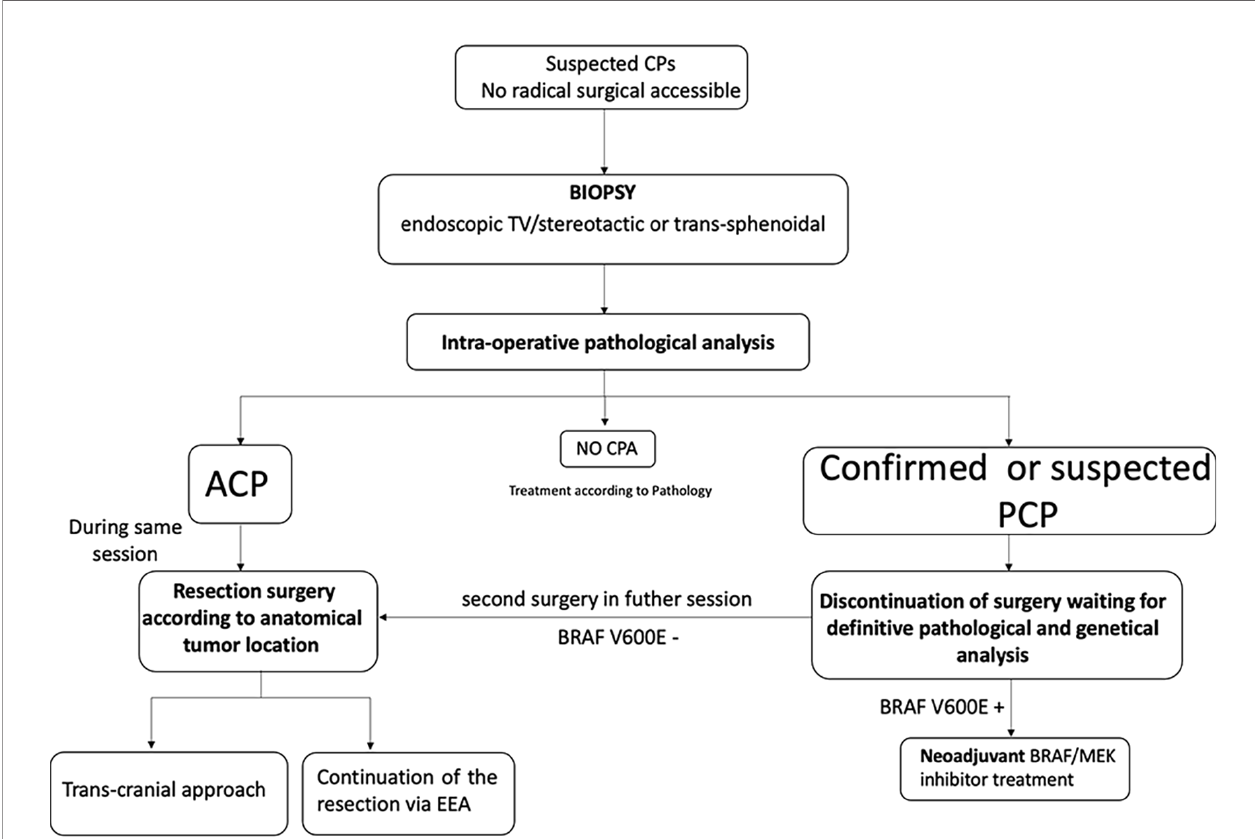
FIGURE 4 | Proposed management algorithm for introperative decision making using pathological analysis on frozen section. Depending on tumor anatomical location, the biopsy can be performed either by stereotactic and neuroendoscopic transventricular techniques or using an endonasal route. In the fi rst case, there will be two surgeries (i.e. biopsy followed by craniotomy for resection if needed) that can be done during the same anesthesia. Conversely, using endoscopic endonasal approach the biopsy could be the fi rst step of the same procedure. See text for more details. CPs, Craniopharyngioma; ACP, Adamantinomatous CPA; PCP, Papillary CPs; EEA, endonasal endoscopic approach; TV,